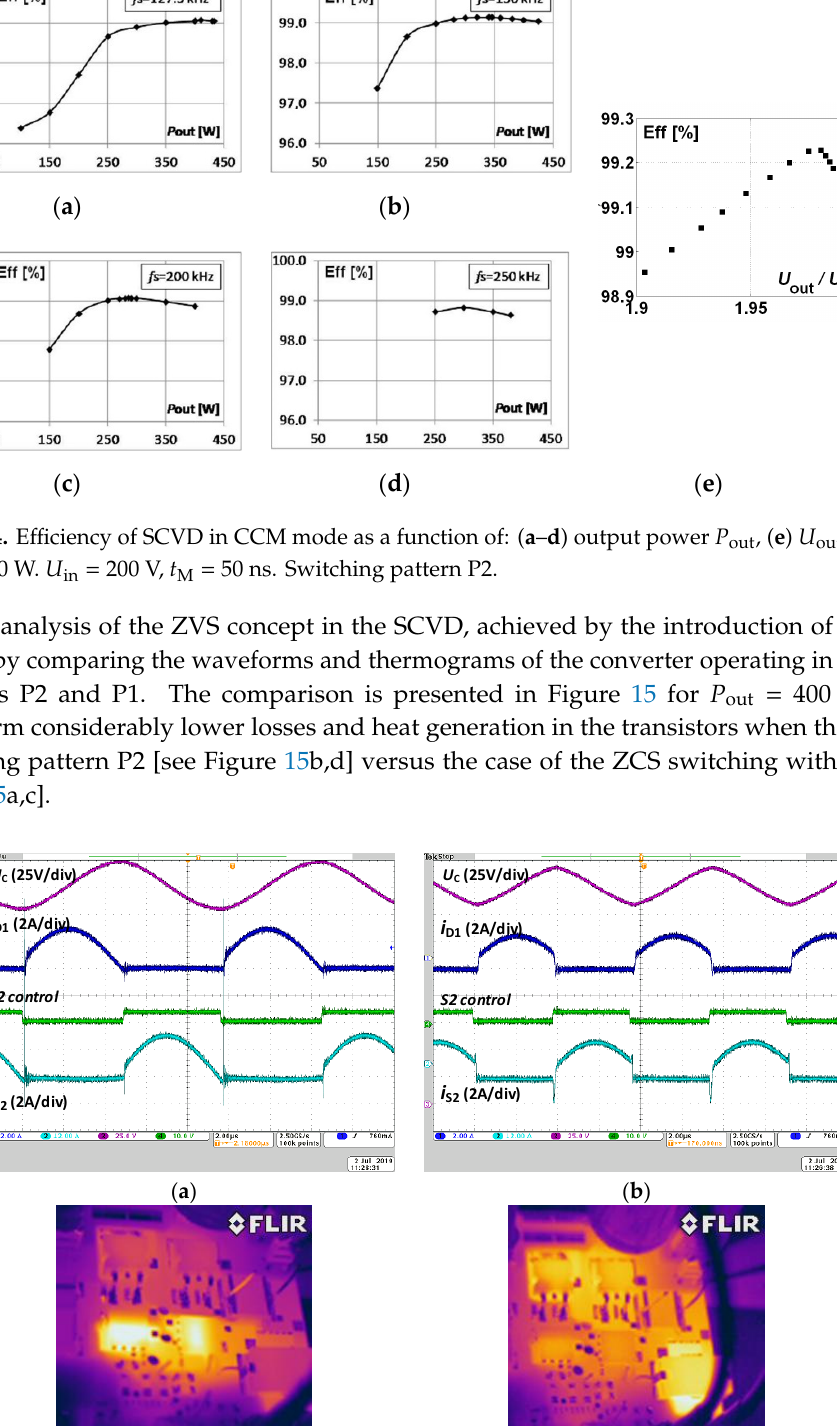
Figure 15. Operation of SCVD in ZCS mode (pattern P1) at f S = 105 kHz with η = 98.30%, and in ZVS mode (pattern P2) at f S = 134.4 kHz with η = 99.228%. Steady-state waveforms of voltage on switched capacitor C , current of diode D 1, control signal of transistor S 2, current of S 2; IR photos of converter. U in = 200 V, P out = 400 W, t M = 50 ns. Results ( a , c )—switching pattern P1, results ( b , d )—switching pattern